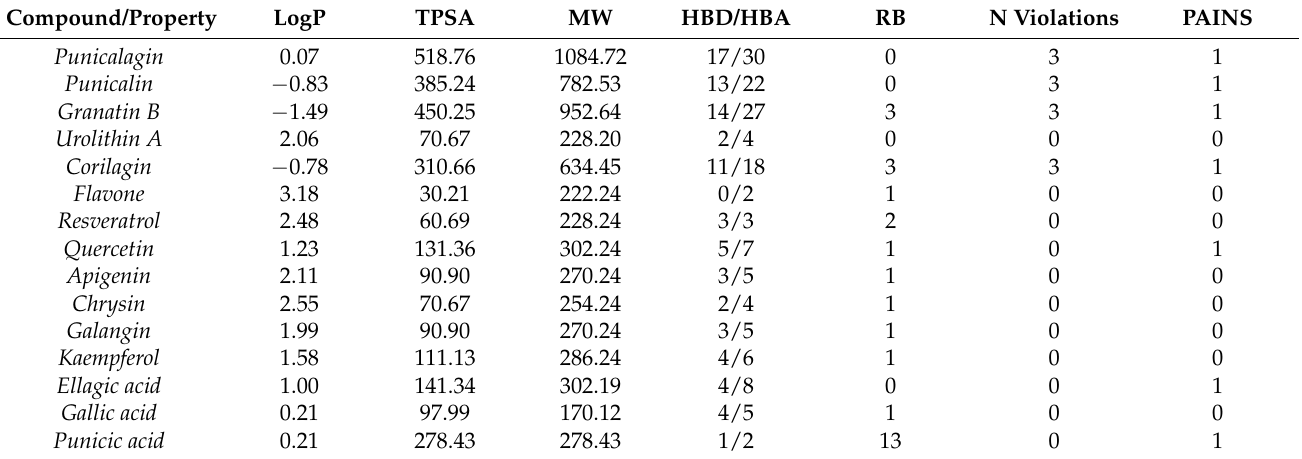
Table 3. Physicochemical properties of the main phytochemicals by